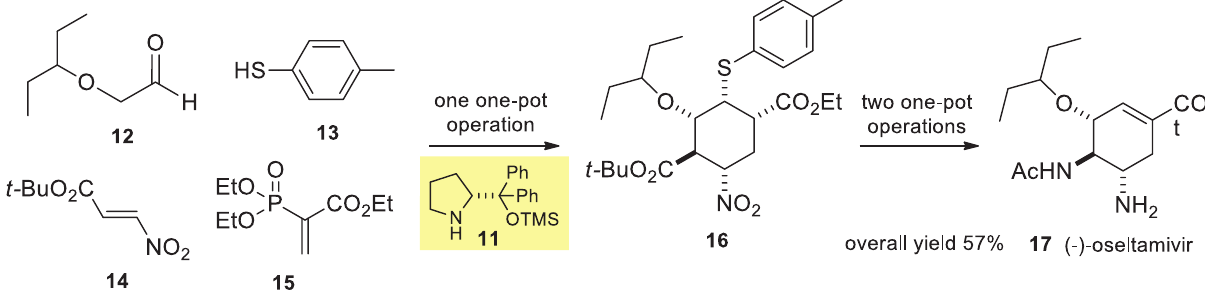
Figure 6 . Olseltamivir enantioselective synthesis, see Ref. [30].